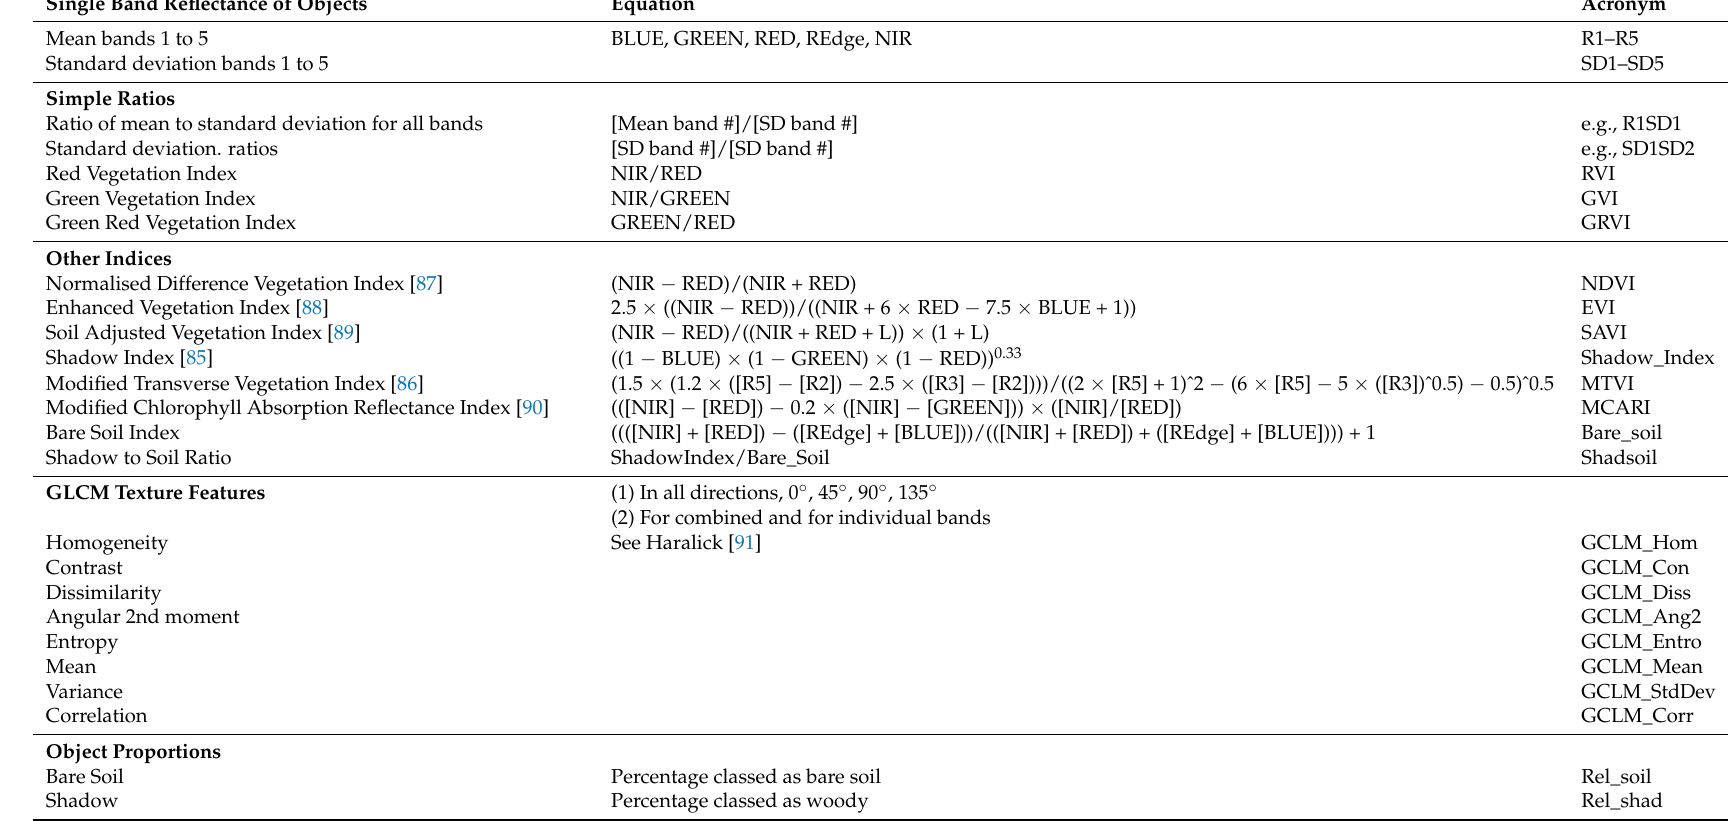
Table 3. List of reflectance and texture measures extracted from the RapidEye